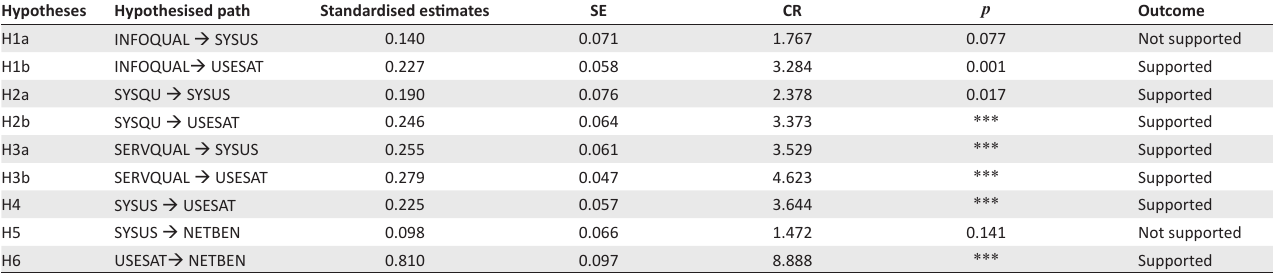
TABLE 4: Hypothesis testing result.